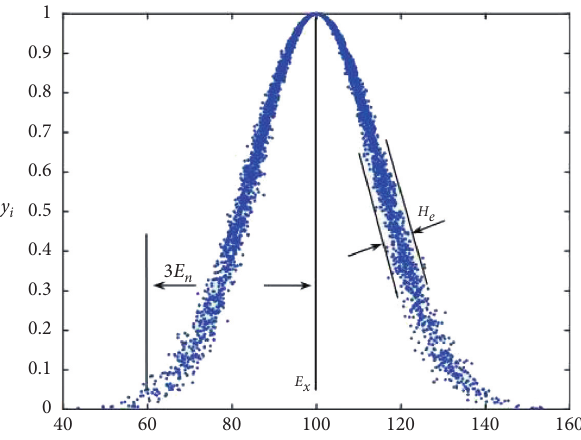
Figure 5: The sketch map about the eigenvalue of cloud.